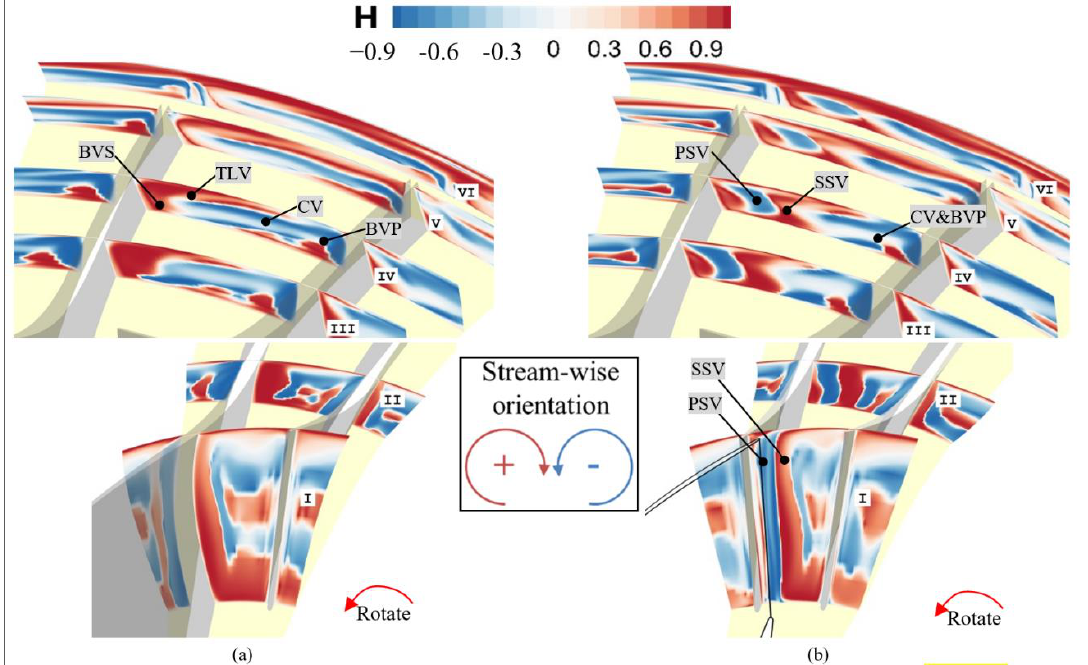
Figure 17. Evolution of the relative helicity within the conventional and baseline tandem impeller passages ( P.E. point). ( a ) Conventional impeller, and ( b ) baseline tandem impeller.